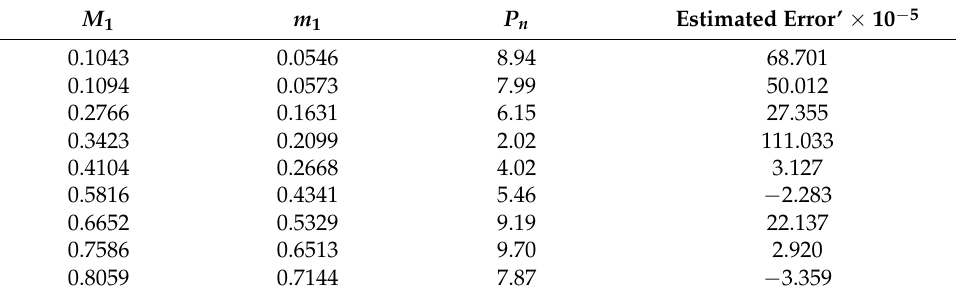
Table 5. The input data for low conversion and r 1 = 0.65 and r 2 = 2.12